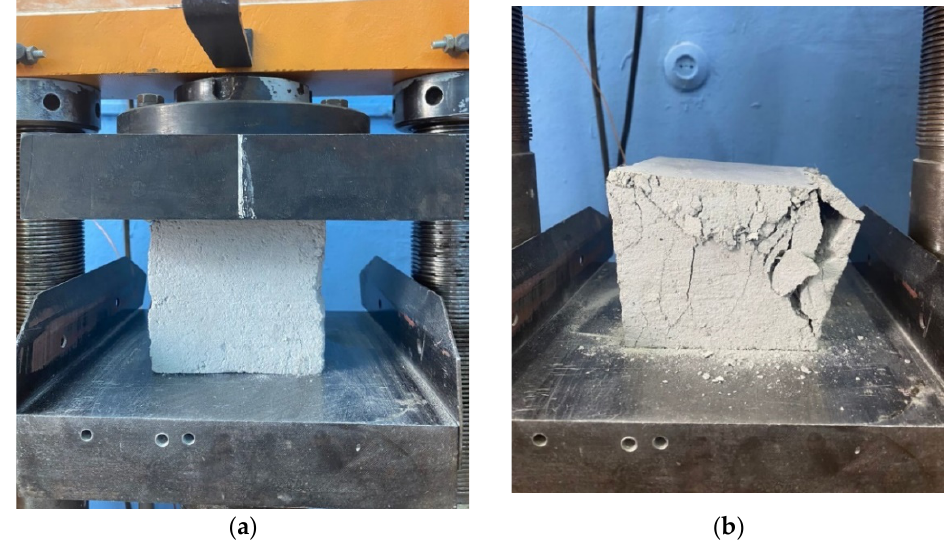
Figure 4. Sample of fiber-reinforced concrete under compression test (graphic scale is 1:3): ( a ) before loading and ( b ) after loading.